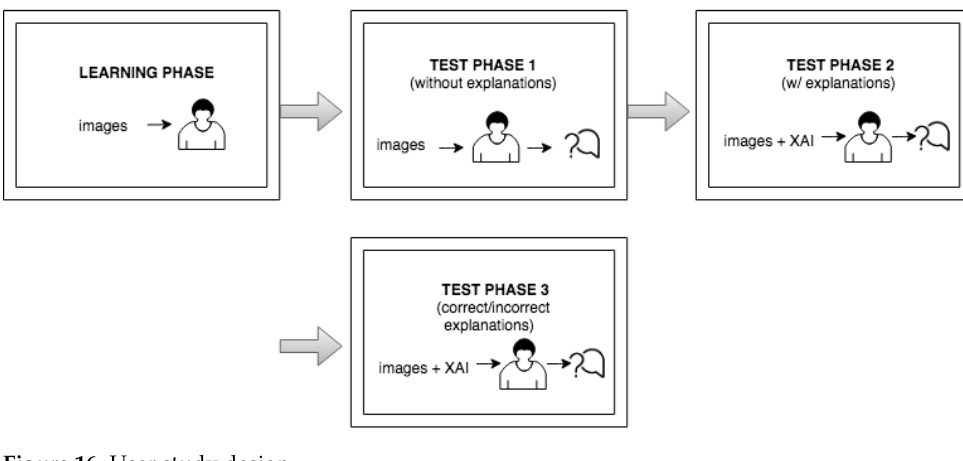
Figure 16. User study